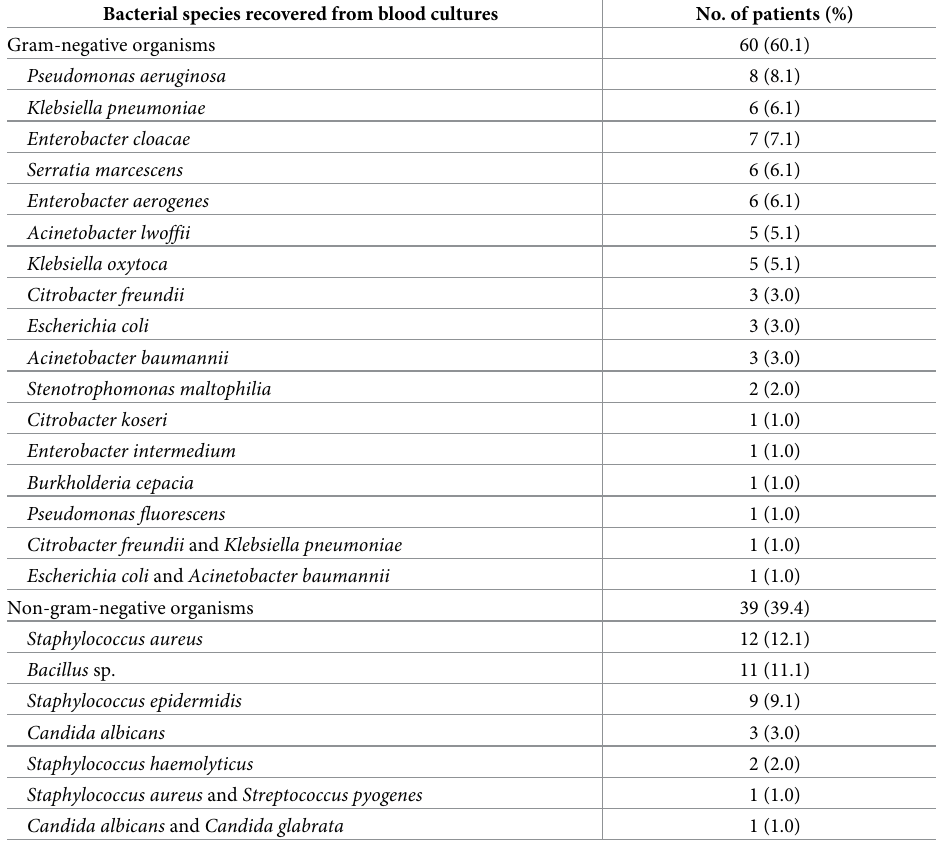
Table 1. Causative organism of peripheral intravenous catheter-associated bloodstream infections. Bacterial species recovered from blood